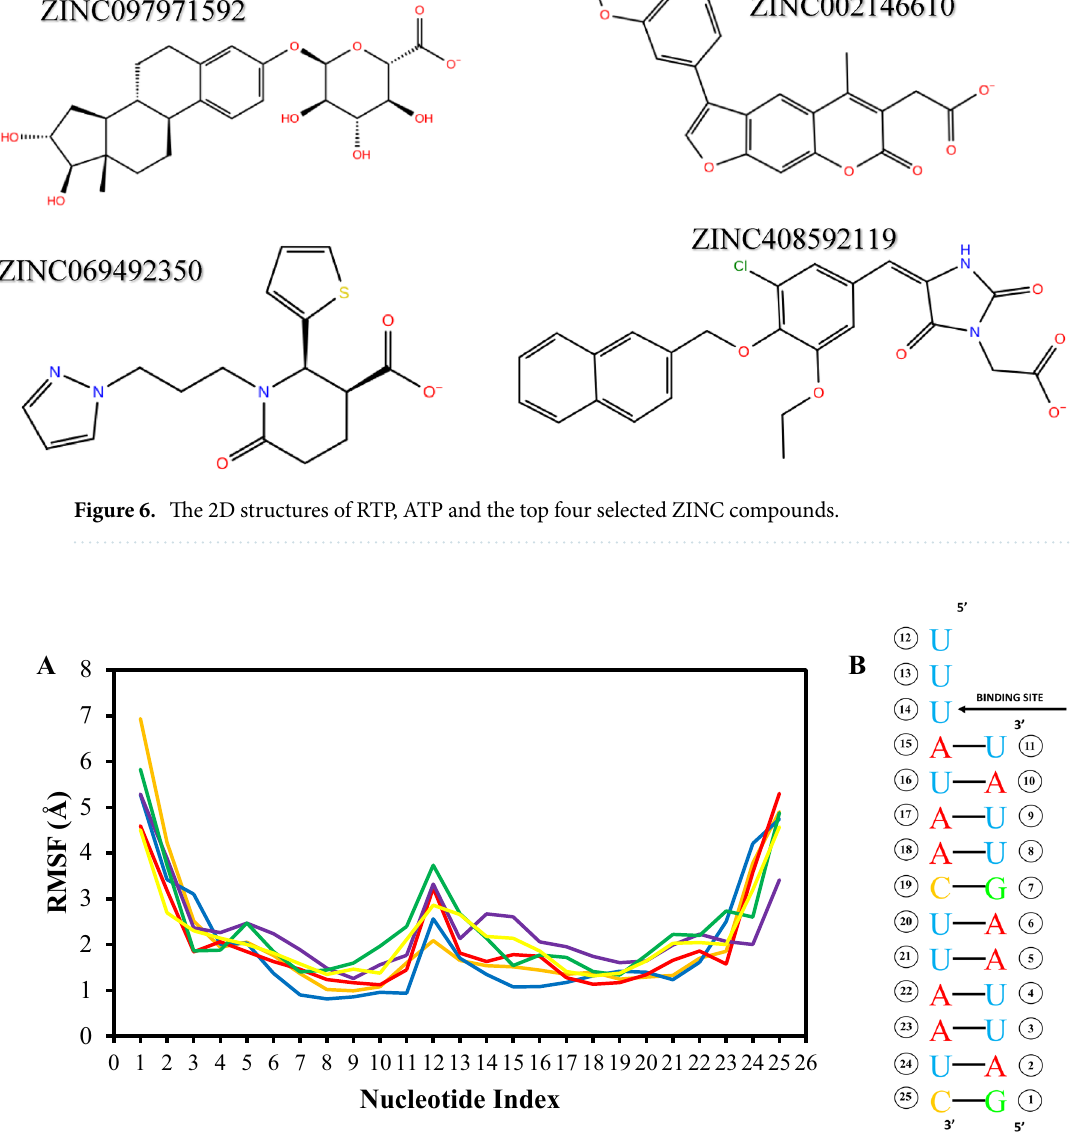
ring with nucleotide U20 on the primer strand and A11 of the template strand of RNA. Additionally, the polar end formed salt bridge and H-Bond interactions with R555 and the nearby Mg + ion. The ligand–protein con- tacts summary for ZINC002146610 shows similar contacts seen in the most abundant pose. Positive amino acid R555 maintained an occupancy of 113% with the polar region of the molecule, meaning there were additional contacts seen with residue in addition to the full simulation time. Like the most abundant pose, the magnesium ion maintained full contact with the polar end via salt-bridge interactions which was seen to be further stabilized by D618. Additional stabilizing water-bridges were established with occupancies of 47% and 48% with D623 and